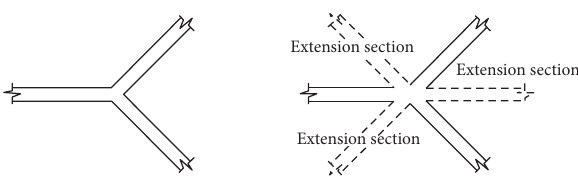
Figure 32: Adding extended segment (Y-shaped).